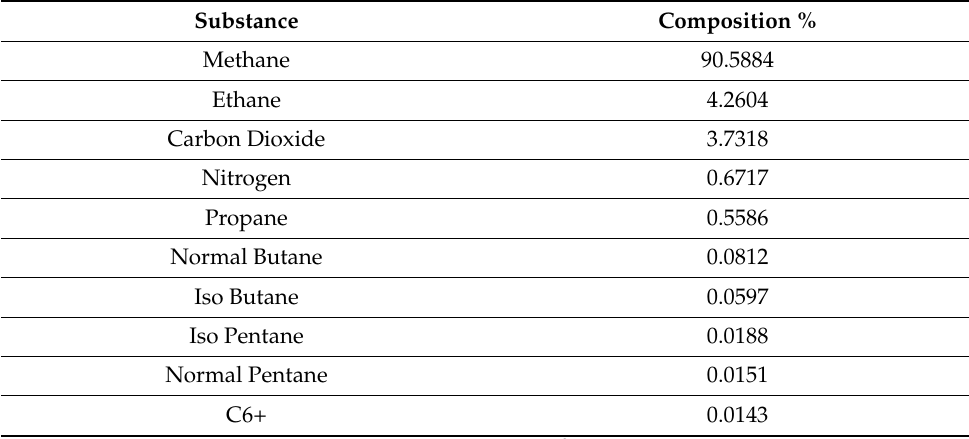
Table 3. Chemical composition of natural gas at pipeline inlet.